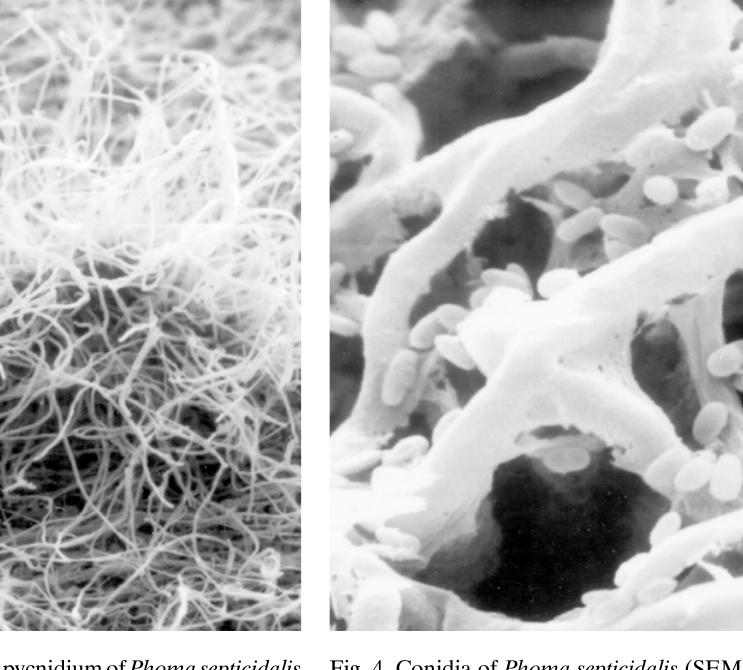
Fig. 3. Setose pycnidium of Phoma septicidalis (SEM x 300). Phot. M. Wróbel.